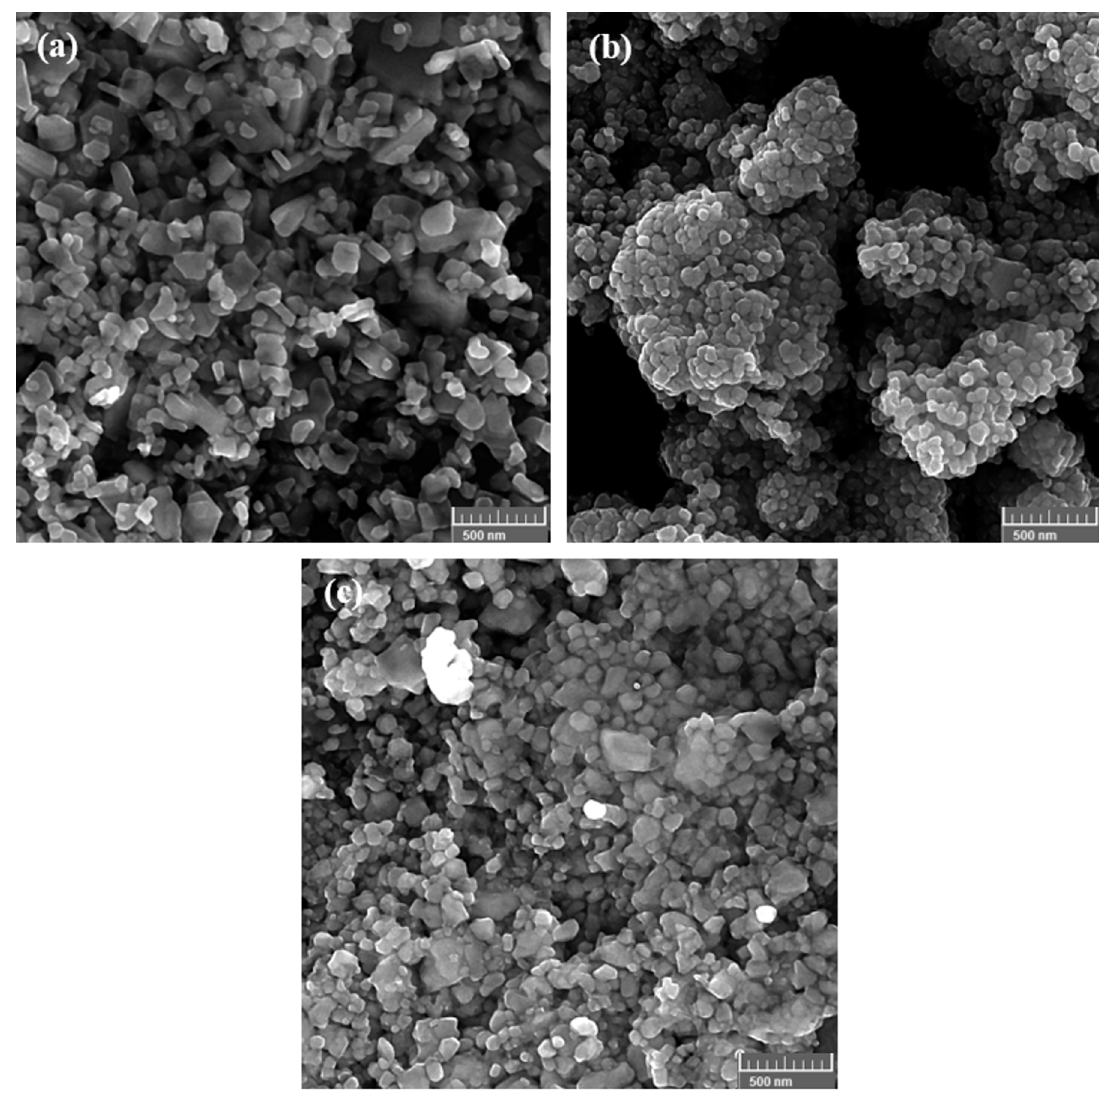
Figure 2. FESEM images of B1, B2 and B3 samples with different amount of oxalic acid and PEG: (a) 65 and 4, (b) 98 and 8.25, and (c) 131 and 2 mmol, respectively.